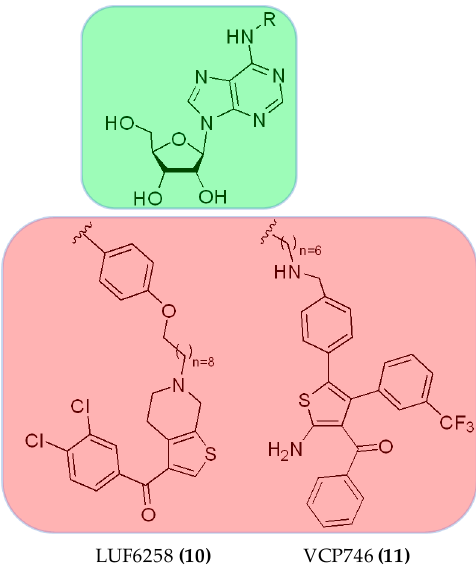
Figure 6. Structures of bitopic ligands 10 , 11 at A1 adenosine receptor. Green: orthosteric building block, red: allosteric building block.